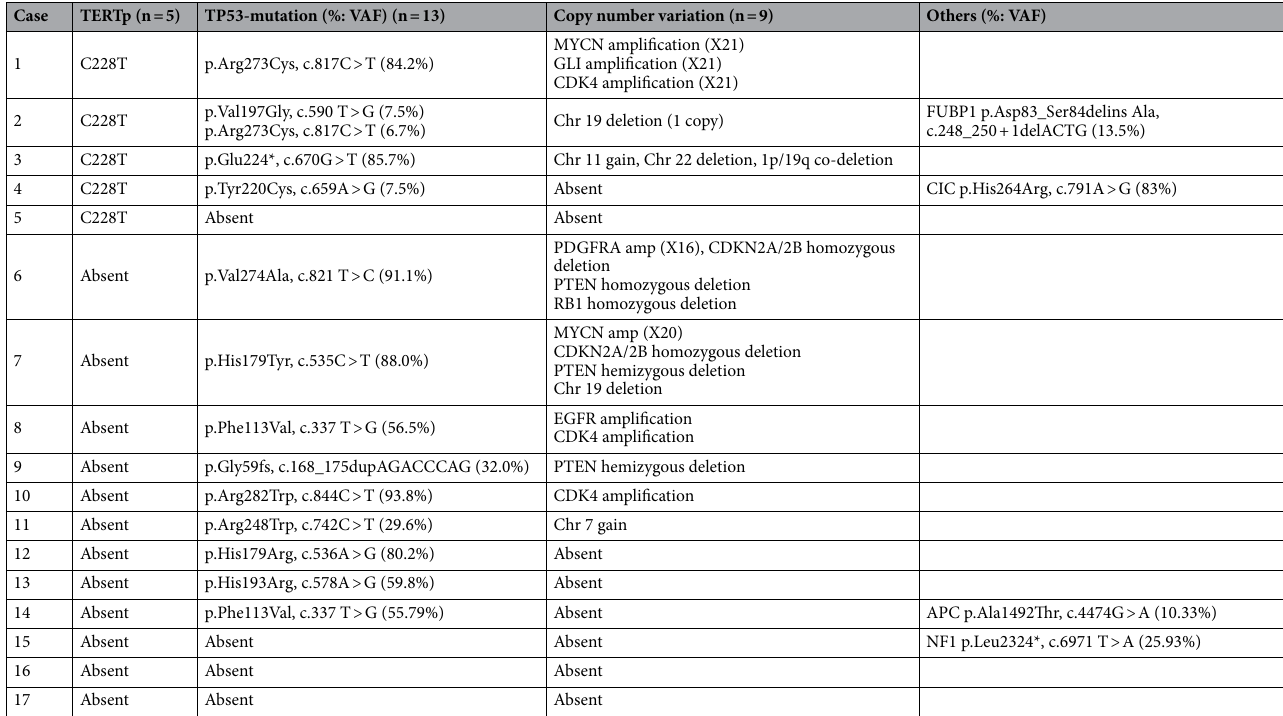
Table 4. Genetic profile of 11 cases of ATRX -intact astrocytoma, IDH-mutant. VAF variant allele